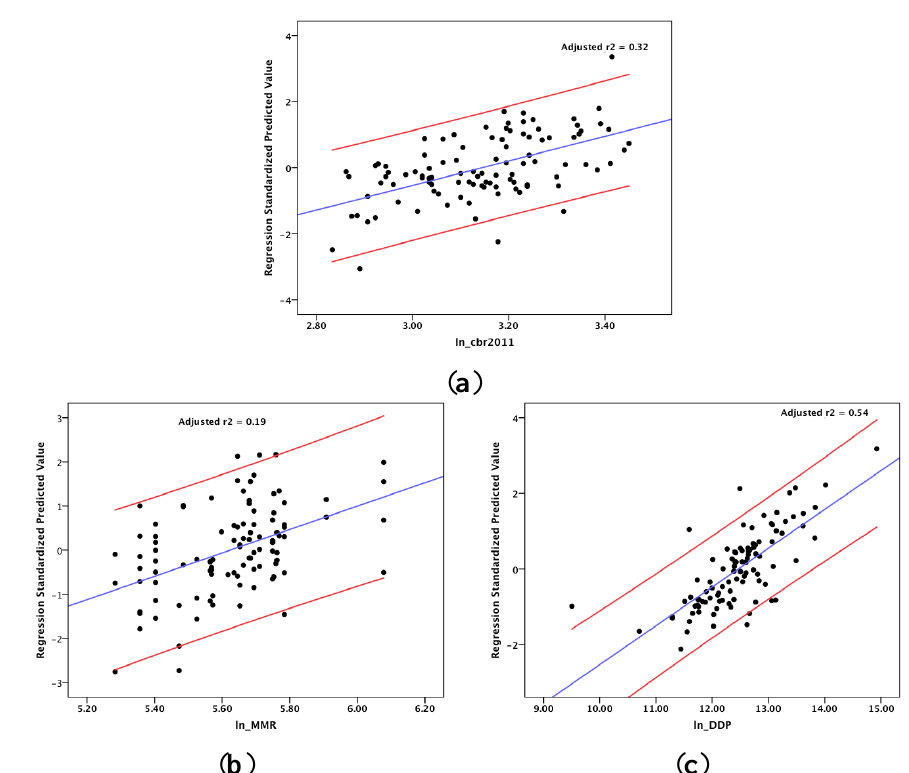
Figure 4. Actual and predicted values of CBR, IMR and DDP: ( a ) CBR; ( b ) MMR; ( c )